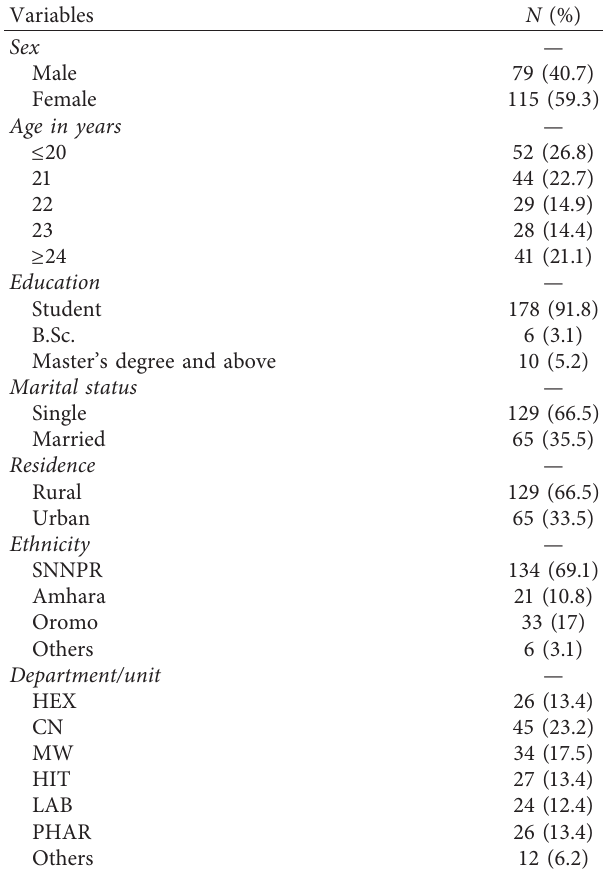
Table 1: The sociodemographic characteristics of respondents.